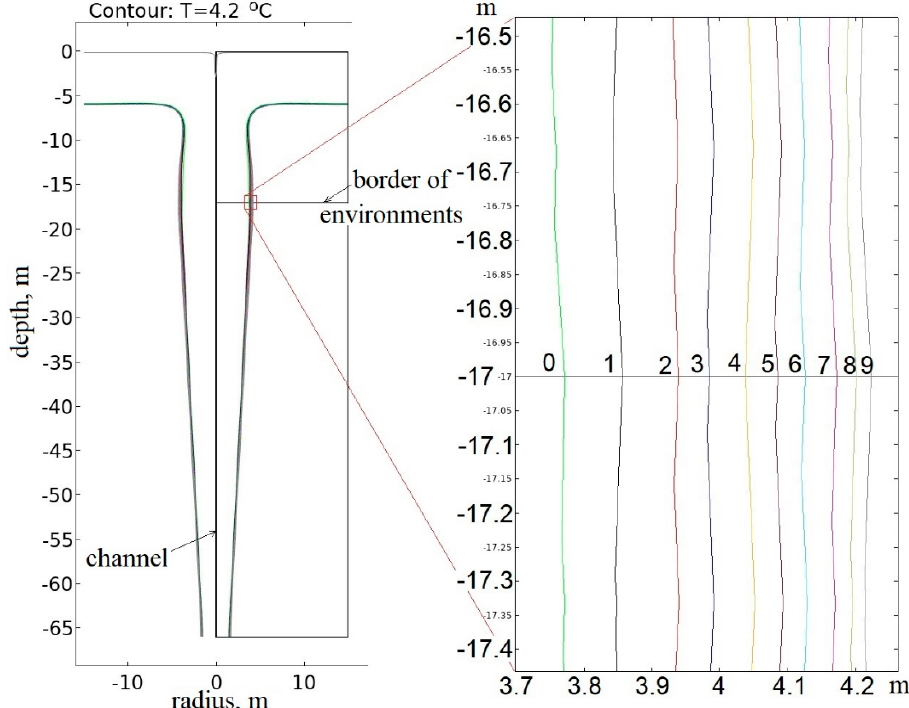
Figure 8. Contour plots of temperature distribution in thawed rock (well t1) at different times. The simulation period is 10 years. The ambient rock temperature is +4 °C and the velocity of water flowing into the cylindrical channel is 100 m/day.